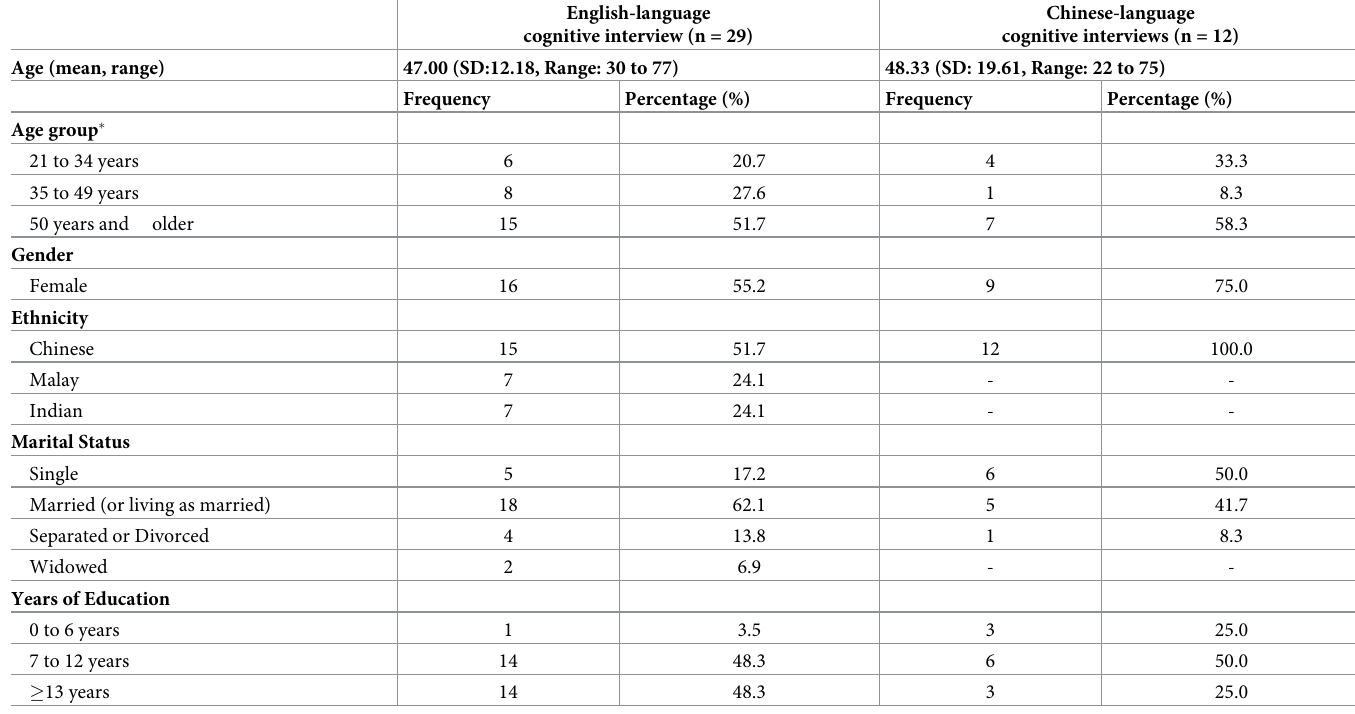
Table 1. Socio-demographic characteristics of English and Chinese cognitive-interview